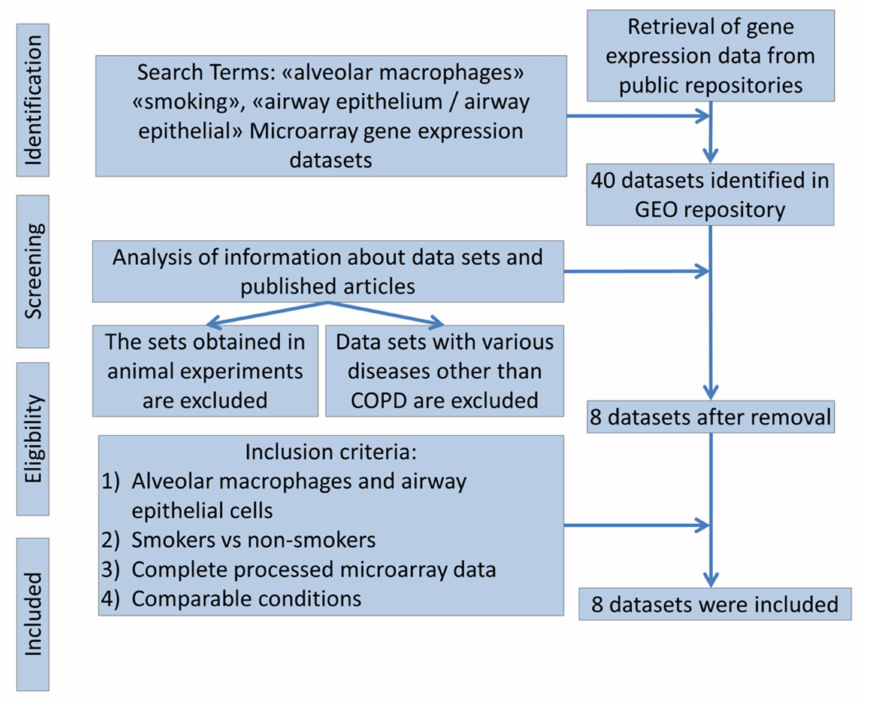
Figure 1. Flowcharts for microarray datasets